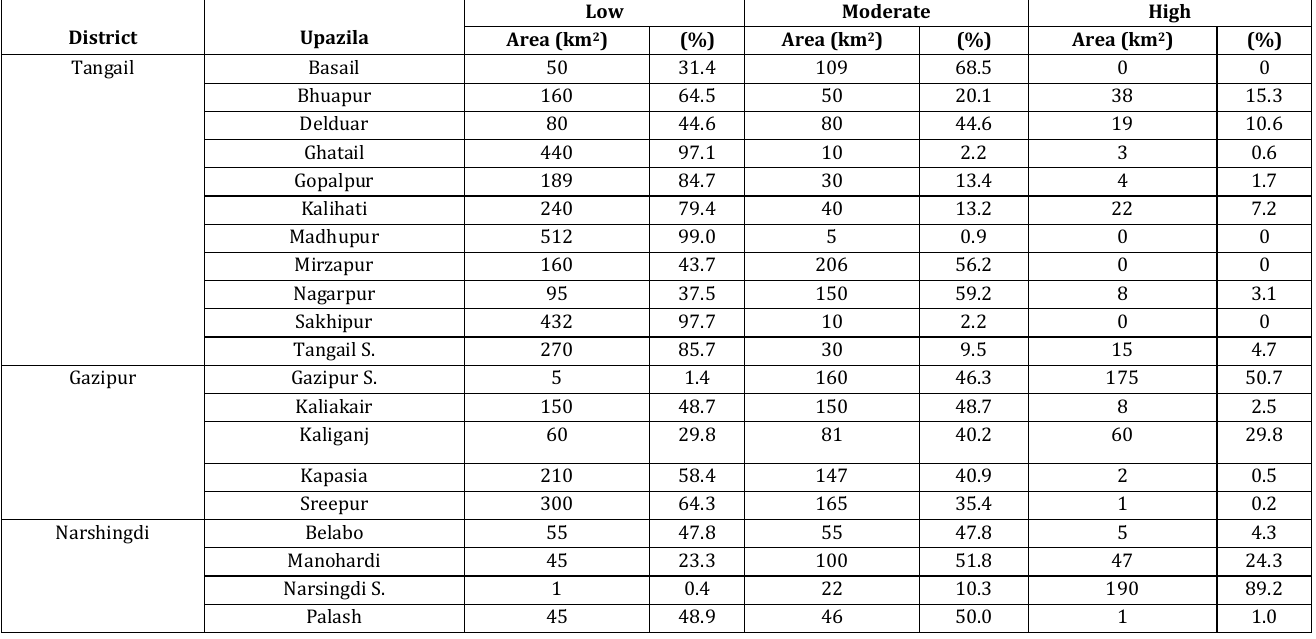
Figure 4: Flood Hazard Index (FHI) map showing flood-risk zones in the study area. Table 6: Flood hazard zones by